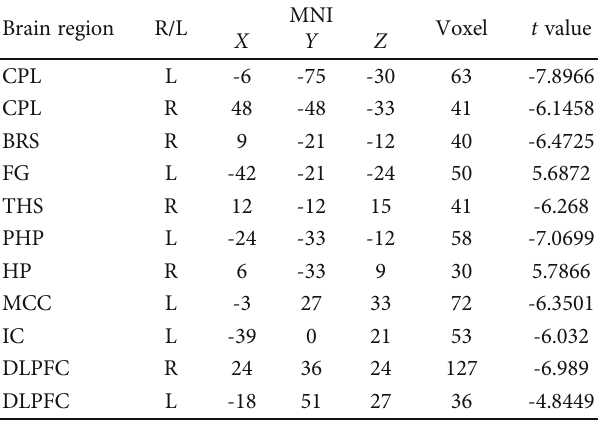
Figure 11: Regions showing signi fi cantly di ff erent EC with the rACC in nocebo status (IG) compared with nocebo status (EG). Table 8: Locations of the regions showing signi fi cantly altered EC with the rACC in placebo response compared with nocebo response in IG ( p < 0 : 05 , FDR < 0 : 05